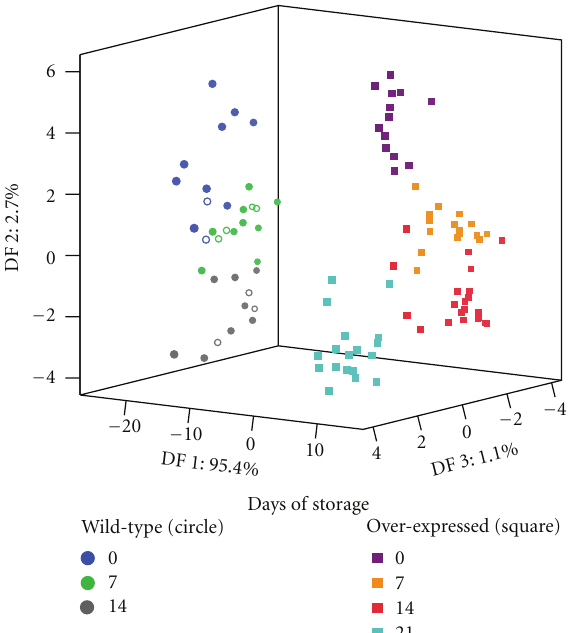
Figure 3: Discriminant function analysis of electronic data for organoleptic mature of wild-type tomato during 0 (blue circle), 7 (green circle), 14 (grey circle) days of storage and overexpressed tomato during 0 (violet square), 7 (orange square), 14 (red square) and 21 (aquamarine square) days of storage.